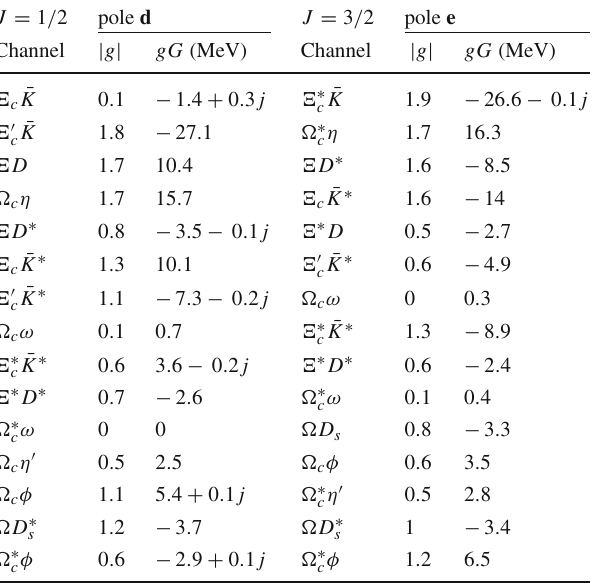
Table 3 Properties of the (cid:2) c ( 2999 . 9 ) and (cid:2) ∗ c ( 3036 . 3 ) states, labeled aspoles d and e ,respectively,obtainedusing α = 1 . 16.Thefirstcolumn displays the different baryon-meson channels coupled to (cid:2) c ( 2999 . 9 ) , ordered by their threshold energies, in the J = 1 / 2 sector. The second and third columns show the absolute value of the coupling and the prod- uct of the coupling times the loop function at the pole position, respec- tively, for all baryon-meson coupled states. The fourth, fifth and sixth columns are equivalent to the first three columns but for (cid:2) ∗ c ( 3036 . 3 ) in the J = 3 / 2 sector J = 1 / 2 pole d J = 3 / 2 pole e